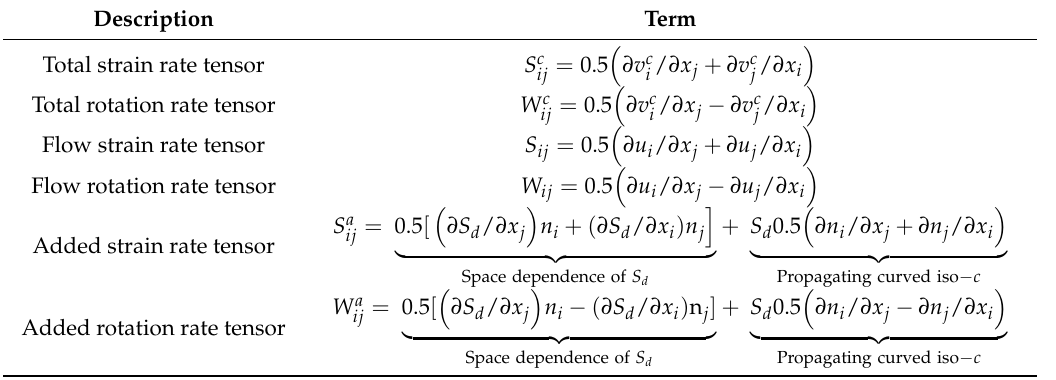
of an iso-surface element. i , j